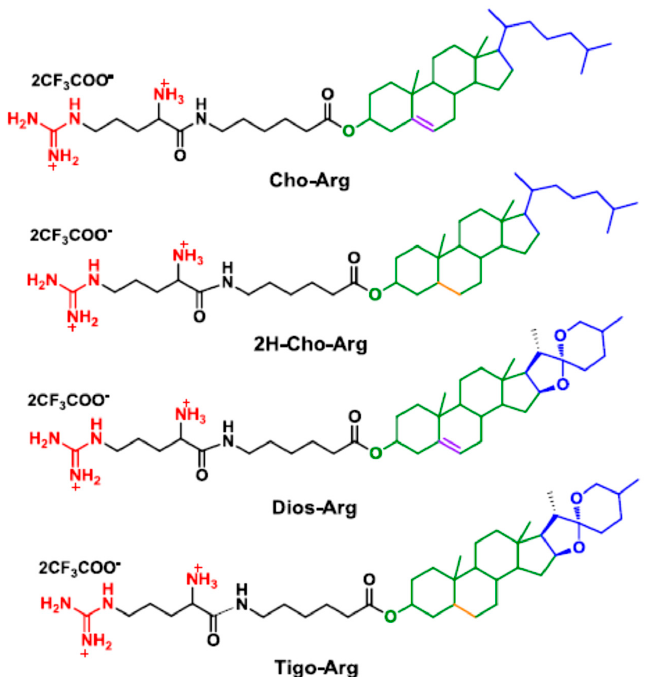
Scheme 1. Molecular structures of the steroid-based cationic lipids. Int. J. Mol. Sci. 2018 , 19 , x FOR PEER REVIEW